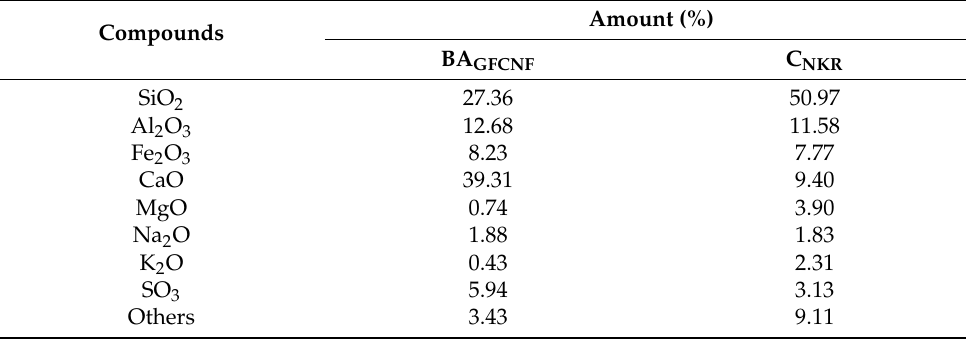
Table 1. Chemical compositions of the raw materials used in this study.